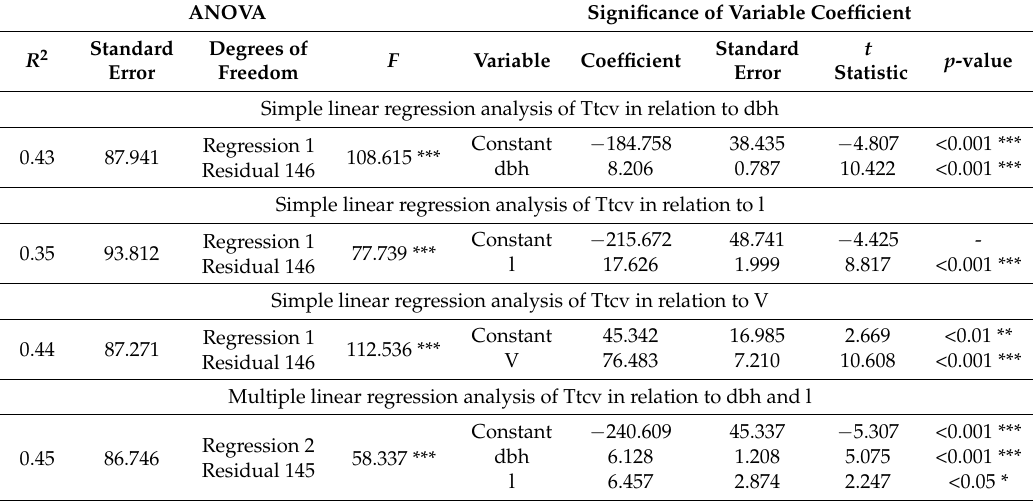
Table 5. Linear regression analysis of the work time consumed for delimbing in relation to the breast height diameter, stem length, and tree volume. ANOVA Significance of Variable